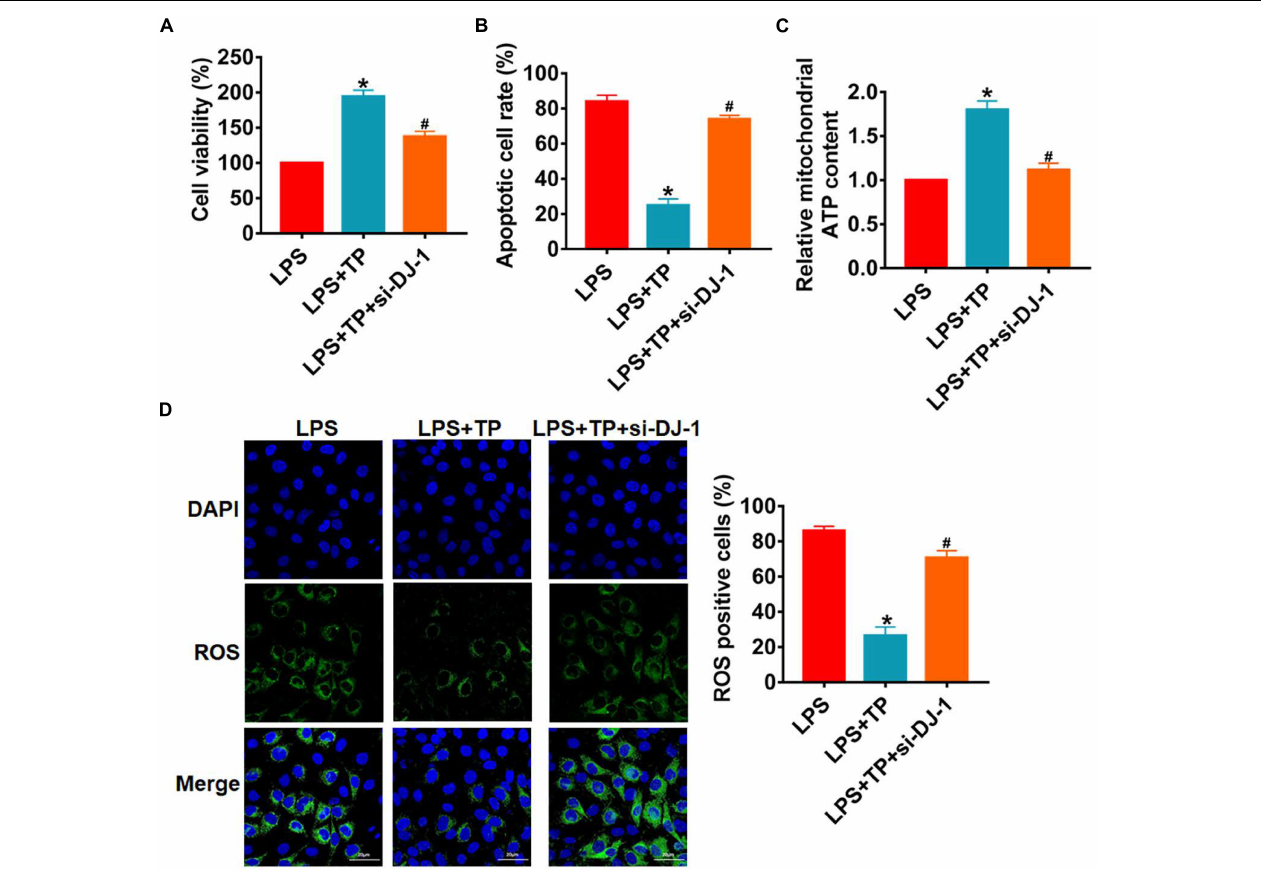
FIGURE 7 | Silencing DJ-1 inhibited the effect of TP on lung cells injury in vitro . L2 cells were treated with LPS with or without TP (15 µ g/ml) and transfected with si-DJ-1 or NC. (A) MTT for cell viability. n = 5, * P < 0.05 vs. control, # P < 0.05 vs. LPS. (B) Apoptosis cell numbers were tested by TUNLE staining. n = 5, * P < 0.05 vs. control, # P < 0.05 vs. LPS. (C) ROS assay for L2 cells. n = 5, * P < 0.05 vs. control, # P < 0.05 vs. LPS. (D) ATP content for L2 cells. n = 10, * P < 0.05 vs. control, # P < 0.05 vs.